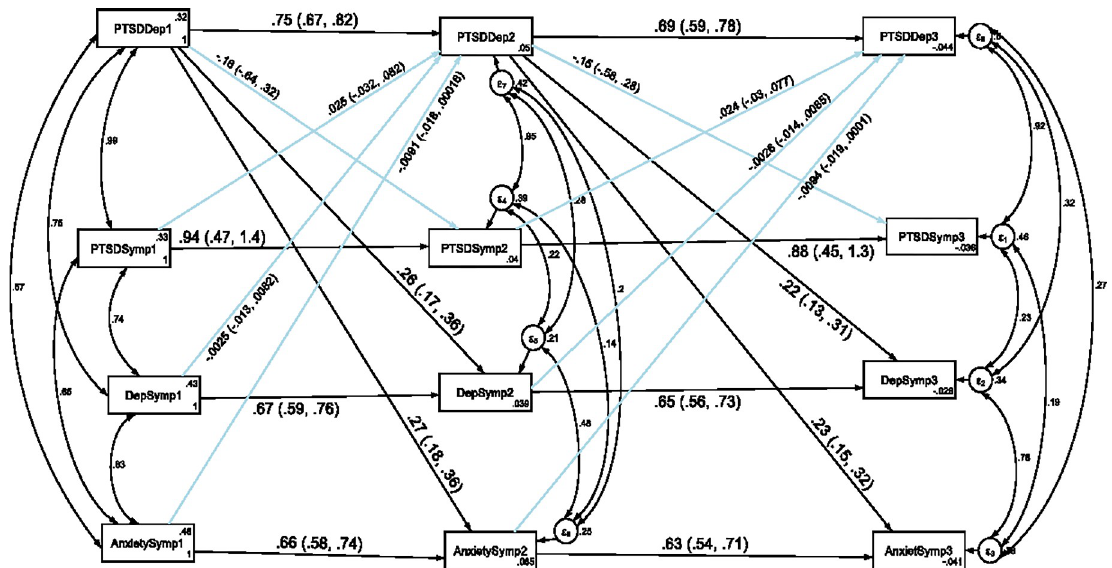
Fig 3. Longitudinal stability and cross-lagged association of depression, anxiety and PTSD with comorbidity of depression and PTSD. Note : All β ’s are standardized estimates with 95% CI.